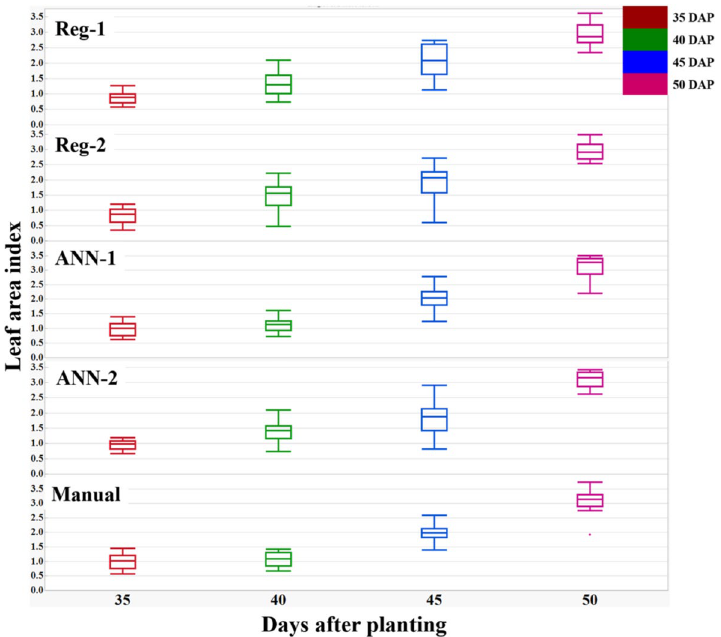
Figure 9. The box and whisker plots show the increase in leaf area index (LAI) over days after planting (DAP), where LAI has been derived using the same models Reg-1: LAI = 28.82 × BGI + 13.77 × PPR-7.91 × NGRD + 14.88 × NCPI + 25.86 × NPPR-39.74; Reg-2: LAI = 505.84 × (BGI × PPR × NPPR × NGRDI × NCPI) + 0.134; ANN-1: BGI, PPR, NPPR, NGRDI, and NCPI as predictors of LAI ; ANN-2: product of BGI, PPR, NPPR, NGRDI, and NCPI as predictors of LAI.